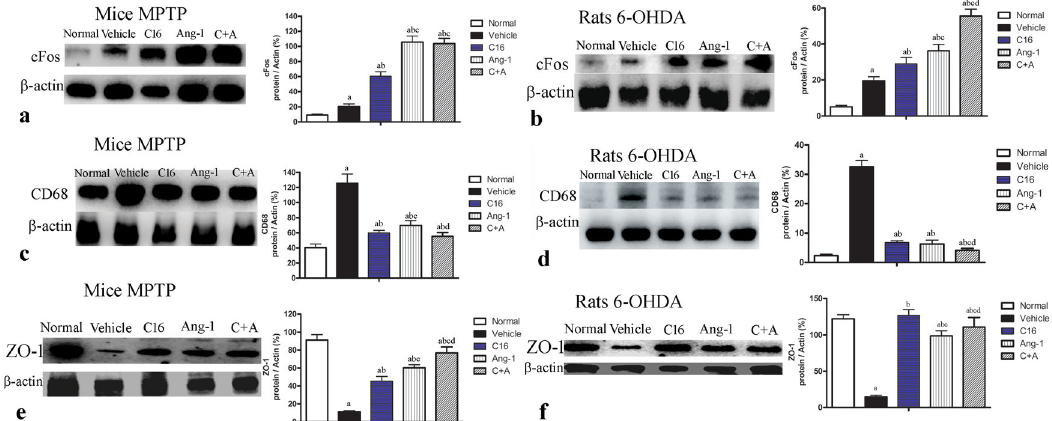
Fig. 5 C16 in combination with Ang-1 treatment suppressed the expression of CD68 but improved the expression of cFos and ZO-1. The expression of cFos ( a : mice; b : rats), CD68 ( c : mice; d : rats), and ZO-1 ( e : mice; f : rats) measured by western blot. Treatment with C16, Ang-1, and C16 plus Ang-1 upregulated cFos ( a , b ) and ZO-1, but reduced the expression of CD68 ( c , d ) in both mouse and rat PD models. a p < 0.05 versus the normal control group; b p < 0.05 versus the vehicle group; c p < 0.05 versus the C16-treated group; d p < 0.05 versus the Ang-1- treated group. cFos protein: 41 kDa; CD68 protein: 37 kDa; ZO-1 protein: 220 kDa; β -actin protein: 42 kDa; ZO-1, zonula occludens-1; C16, peptide (KAFDITYVRLKF) that can selectively bind integrin α ν β 3 ; Ang-1, angiopoietin-1; PD, Parkinson ’ s